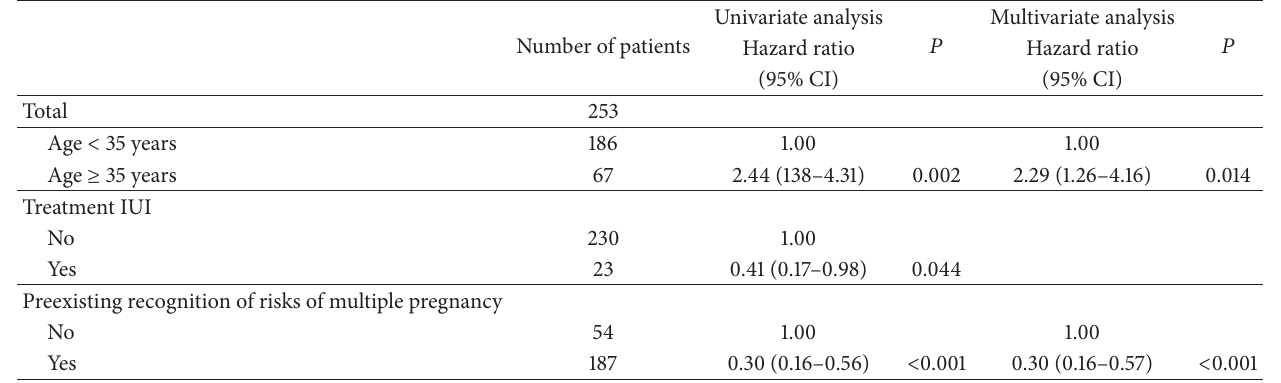
Table 3: Univariate and multivariate analysis of predictors for multiple pregnancies outcome.